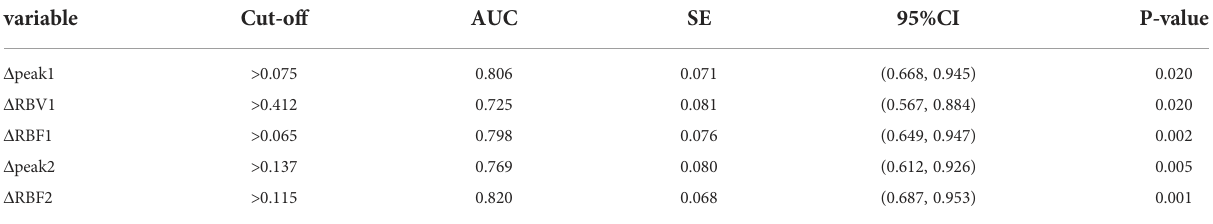
TABLE 3 Diagnostic Performance of TIC parameters in ROI 1 and ROI 2 to Predict Response after 1st cycle of NAC. variable Cut-off AUC SE 95%CI P-value